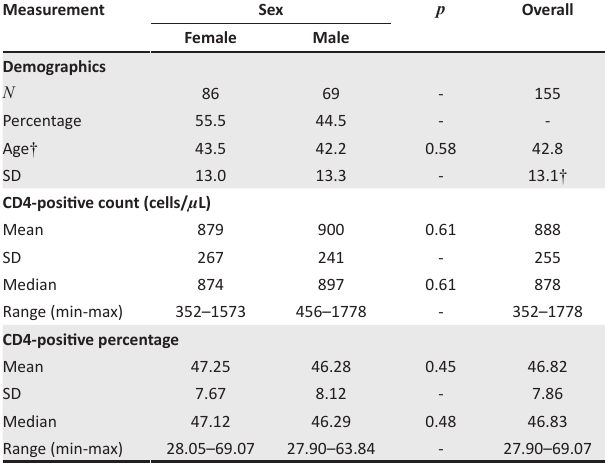
TABLE 3: Demographic characteristics and means, medians, and ranges for CD4 and percentages for a healthy adult reference interval, Canada; Paris, France; and United States, December 2014 to February